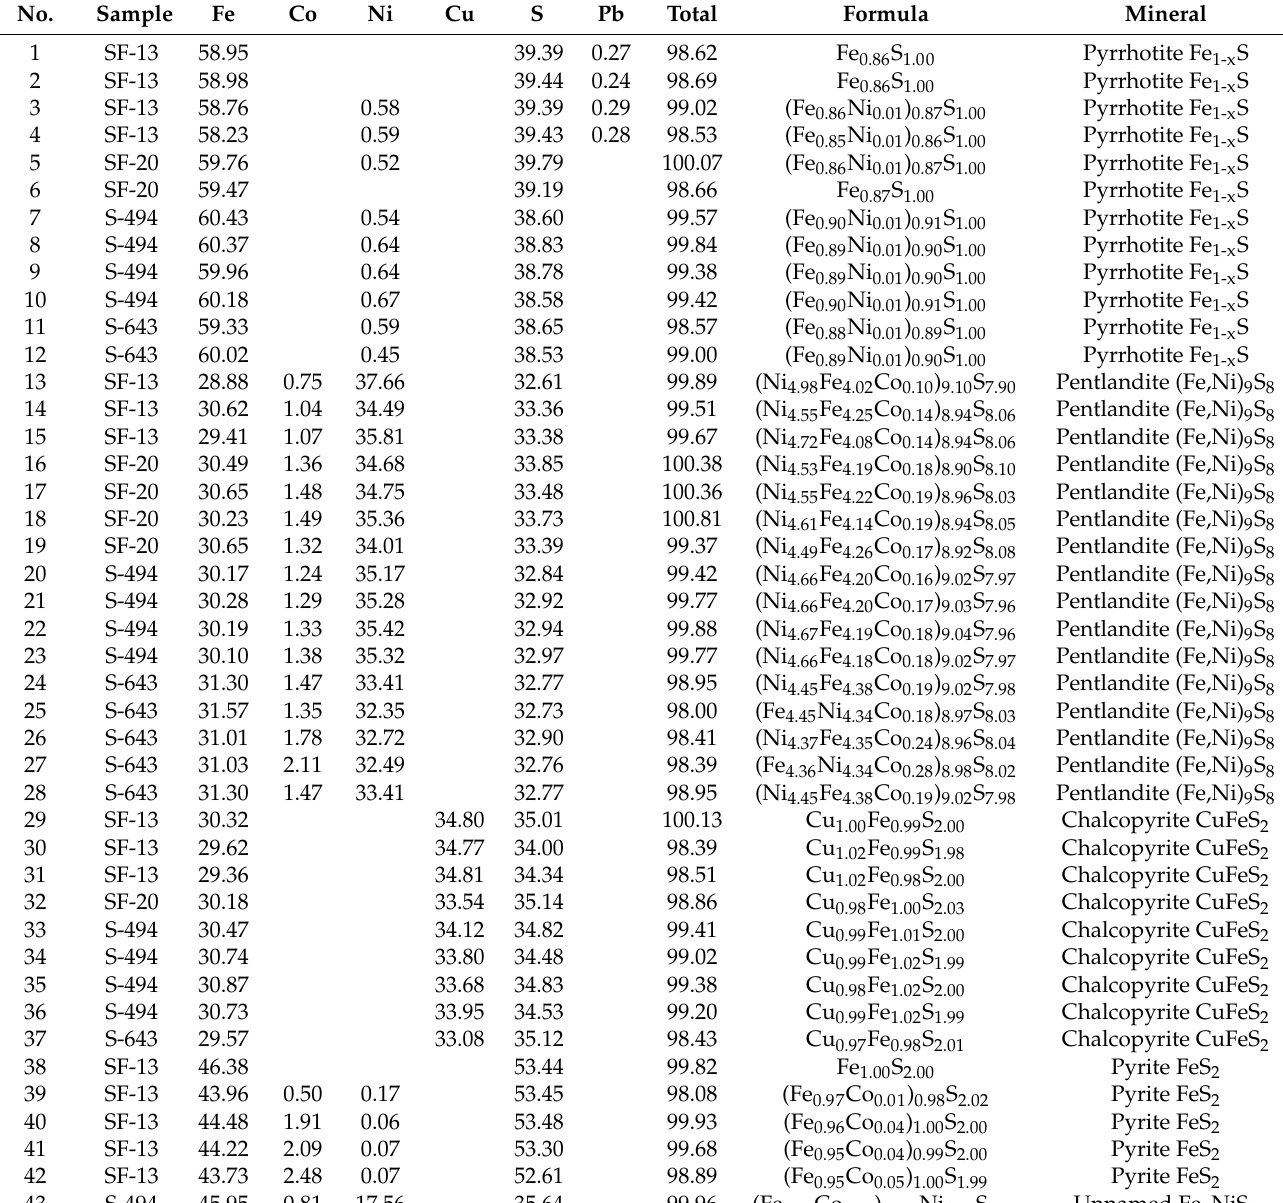
Table 1. Compositions of sulfides from samples SF-13, SF-20, S-494, and S-643